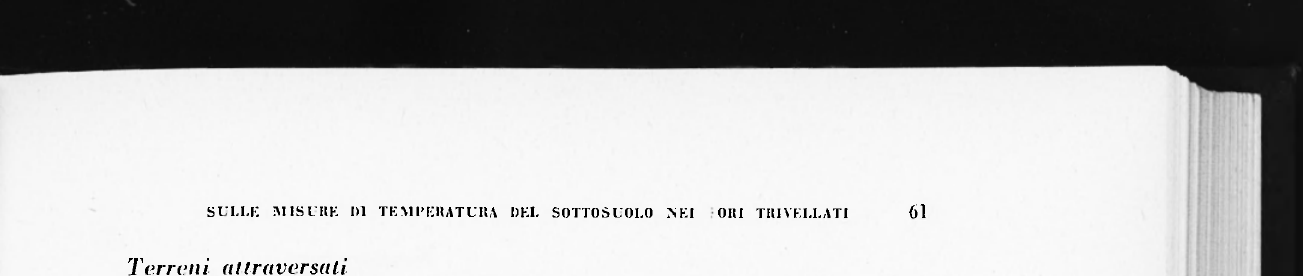
Fig. I - Foro IFYI. Variazioni della temperatura e del pelo libero dell'acqua du- rante l'approfondimento del sondaggio.